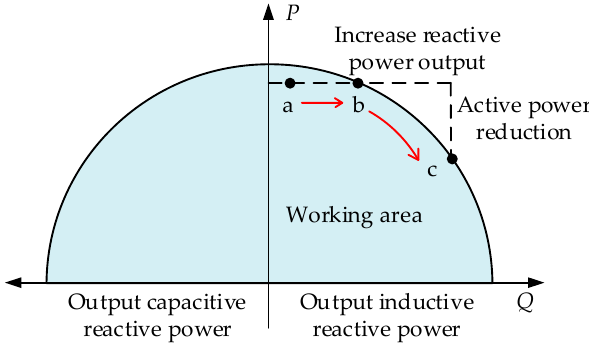
Figure 3. The relationship between reactive power capacity and active power output of PV.